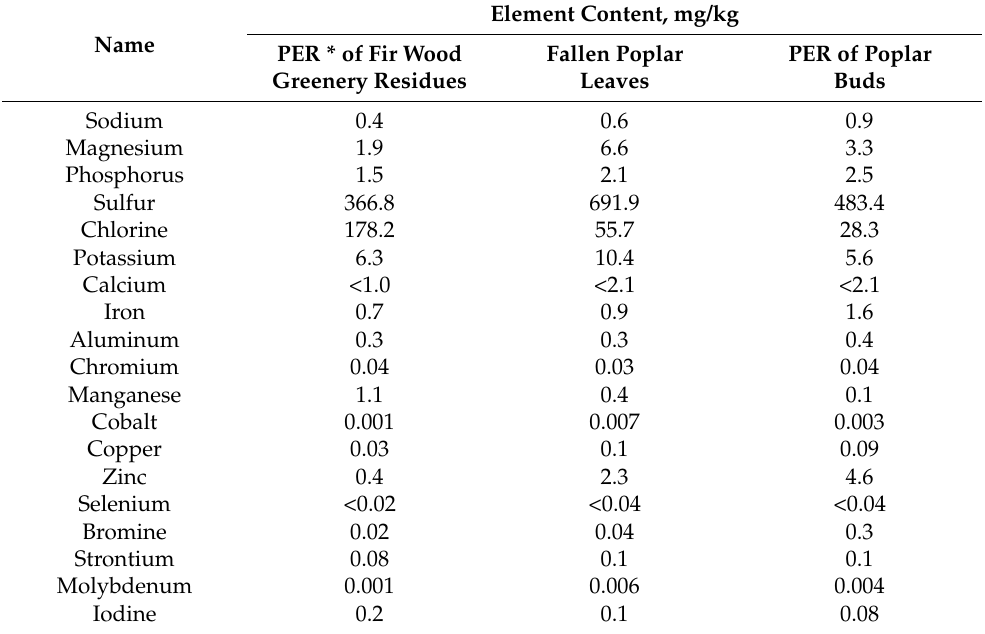
Table 2. Mineral content in the initial raw